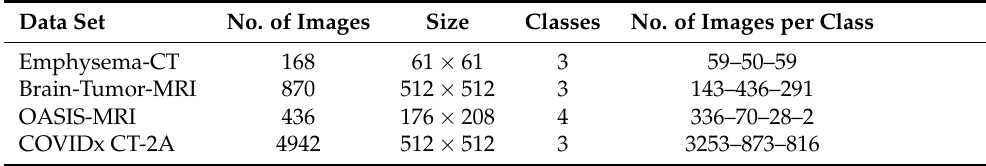
Table 2. The table provides information on the four different data sets used in this research. For each data set, the following details are given: number and size of the images, number of classes, and number of images per